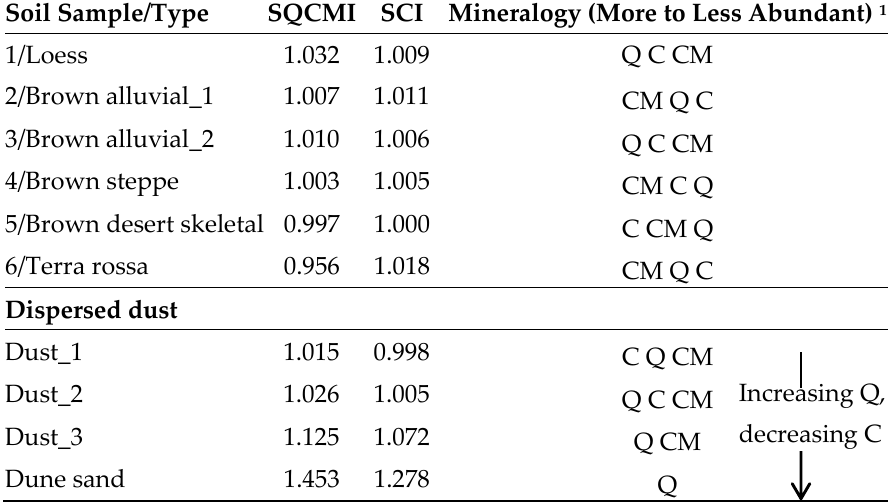
Table 1. Spectral indices and mineralogy of soil samples and dispersed dust.